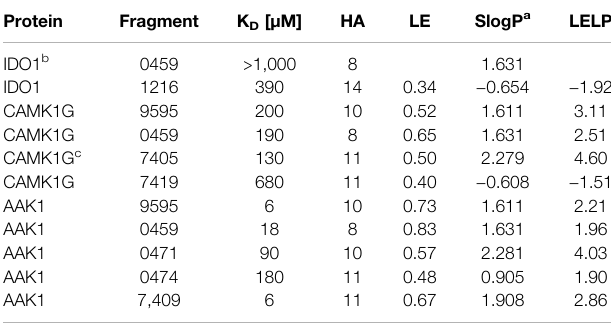
TABLE 4| Af fi nities andfragmentmetrics ofallveri fi ed fragmentswithanaccurate af fi nity estimation in the ITC. LE is de fi ned as LE (cid:1) 1 de fi ned as LELP (cid:1) logP , and K D -values were calculated from duplicates with a LE standard deviation <